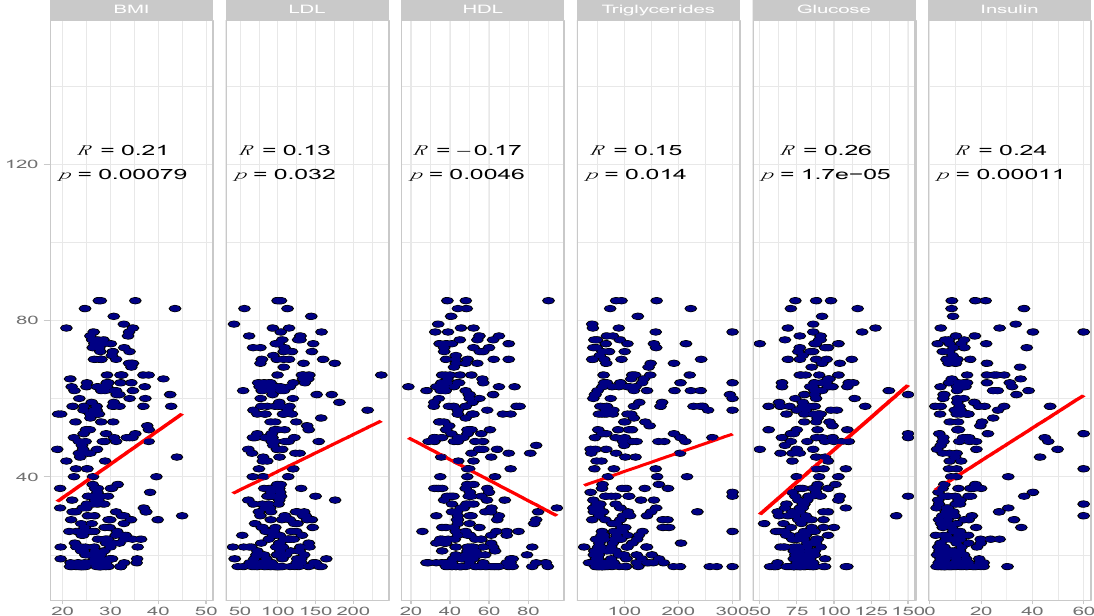
Figure 1. Phenotypic associations between MetS components and PCL score. Table 1. Correlation estimates between CAPS score and metabolic traits in the SBC dataset. Pearson Correlation Spearman Rank